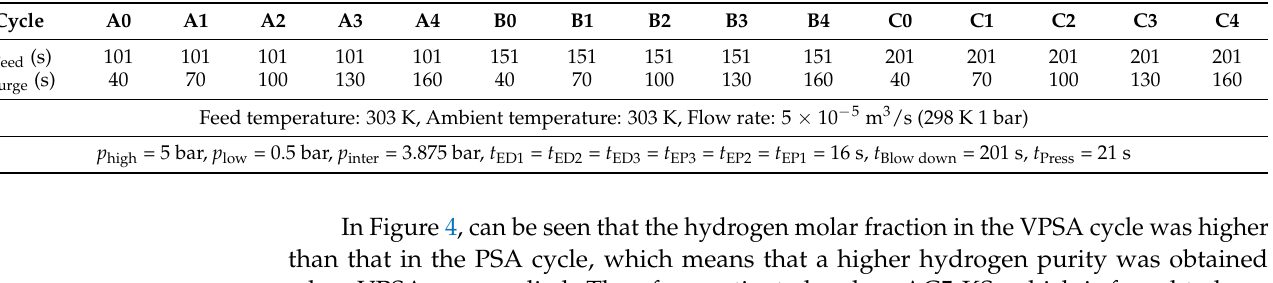
Table 4. Operating conditions used in VPSA